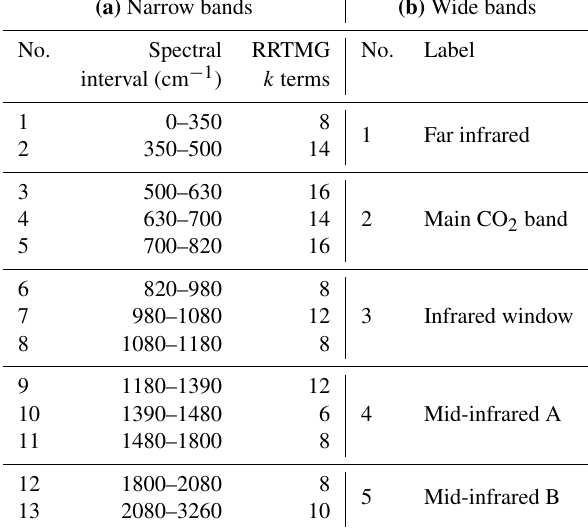
Table 5. The spectral boundaries of the (a) “narrow” and (b) “wide” longwave bands, in which participants are asked to generate CKD models. The narrow bands are essentially the same as those in RRTMG, except for the final band which spans the last four bands of RRTMG. The band boundaries are depicted in Fig.